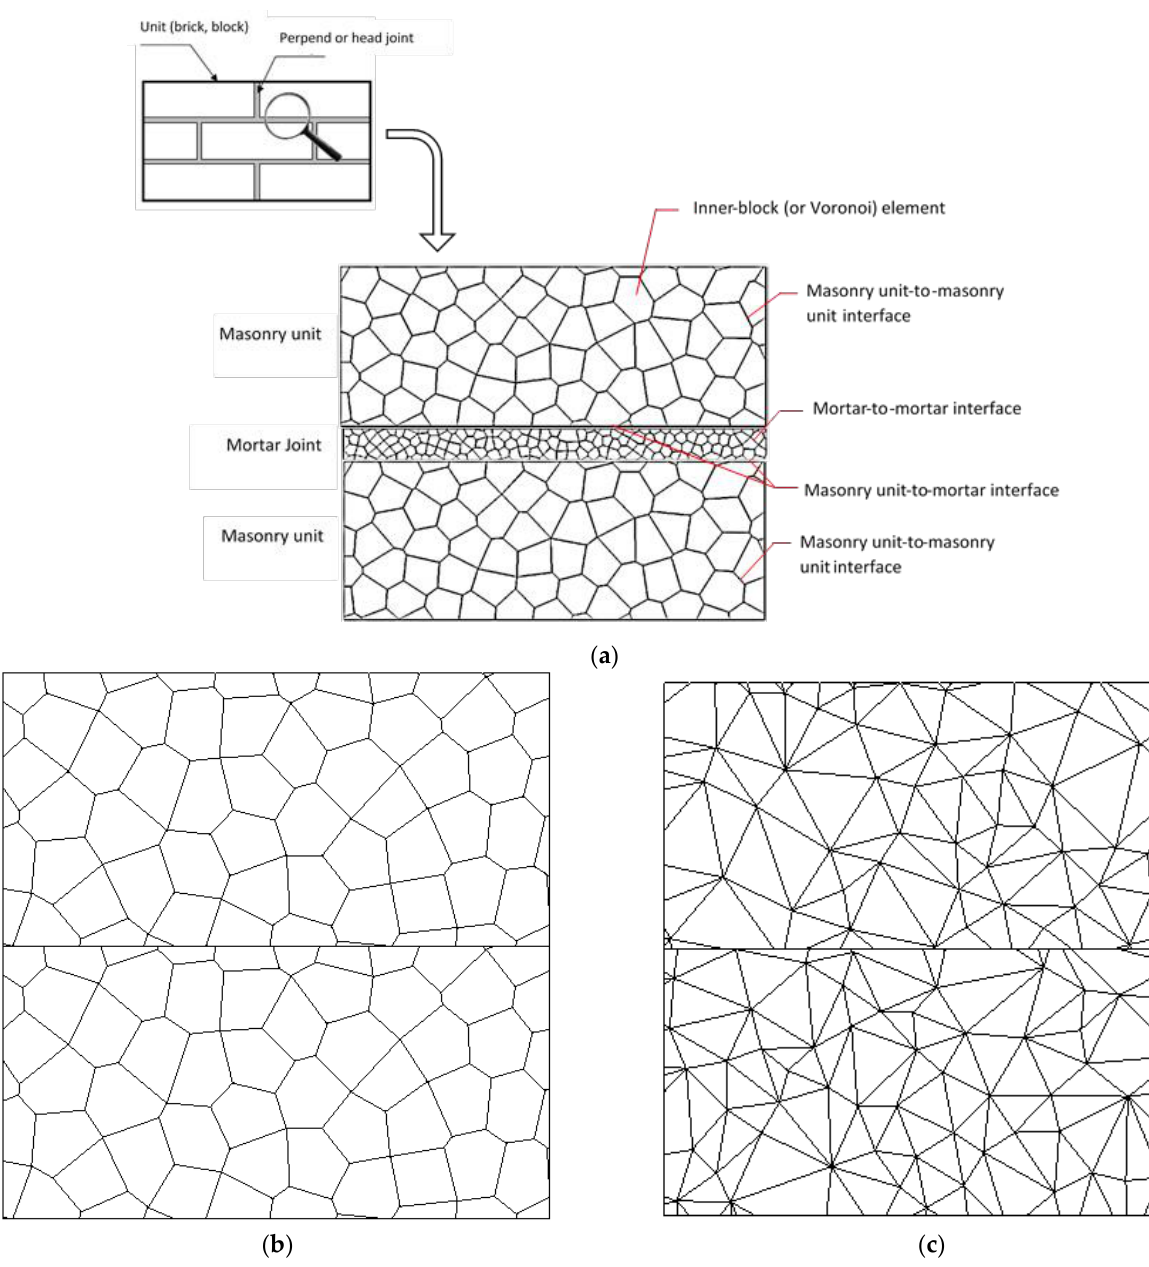
Figure 1. Representation of masonry units and mortar joints by means of polygonal elements ( a ). Representation of units by Voronoi inner-blocks ( b ); or triangular inner-blocks ( c ).